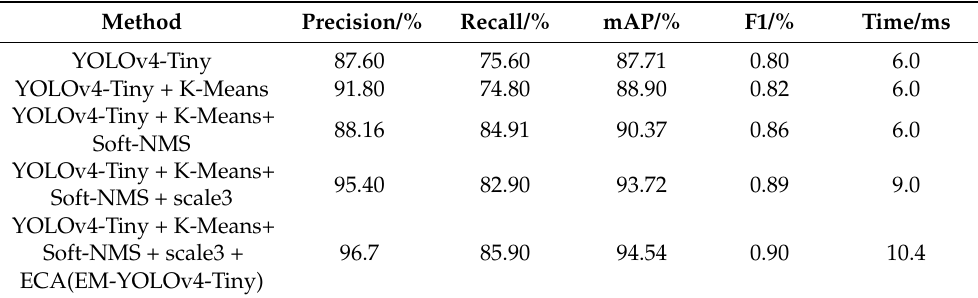
Table 4. Influence of different improved modules on YOLOv4-Tiny network.